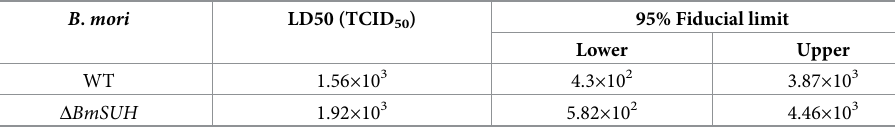
Table 3. LD50 of fifth instar larvae after BV injection.